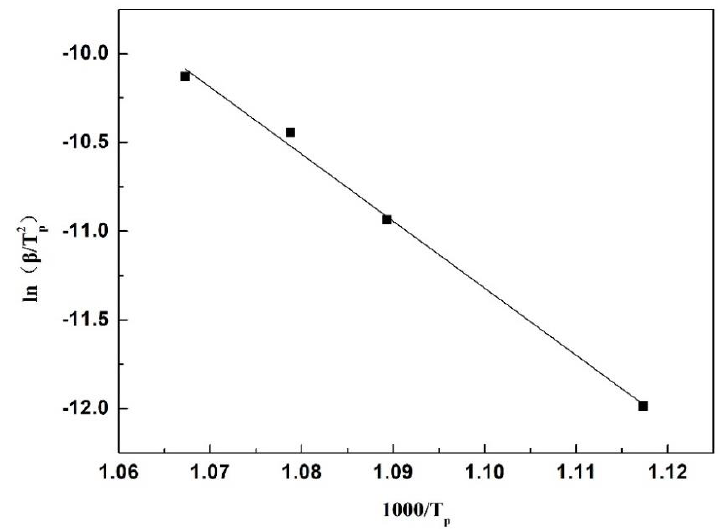
Figure 9. Relationship between ln( β/Tp 2 ) and 1/T P of No. 1 slag.